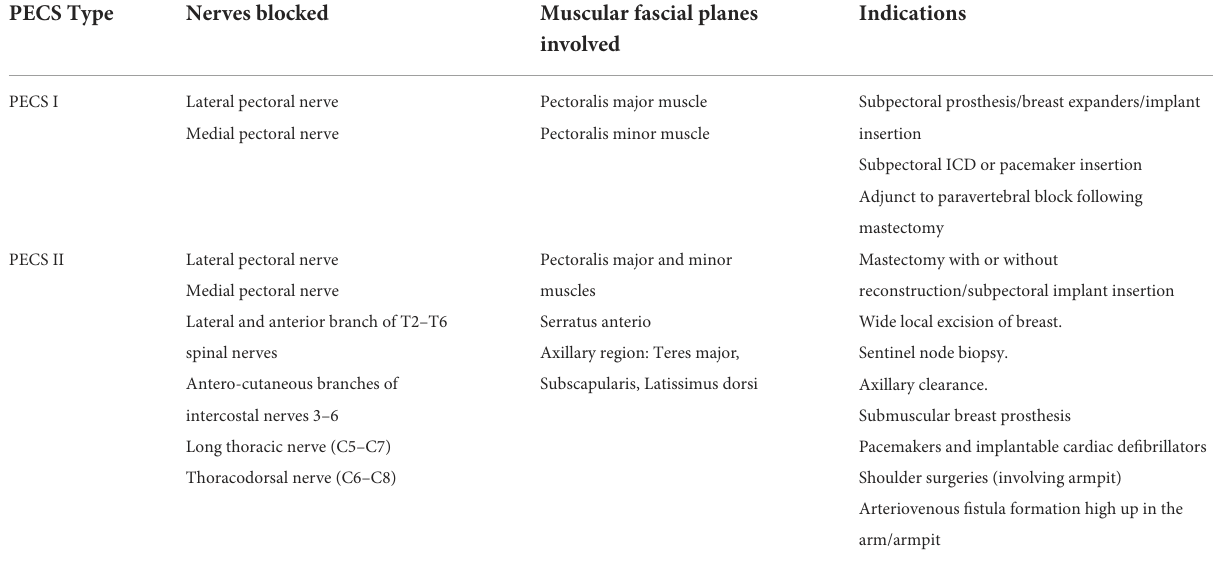
TABLE 1 Characteristics of PECS I and II